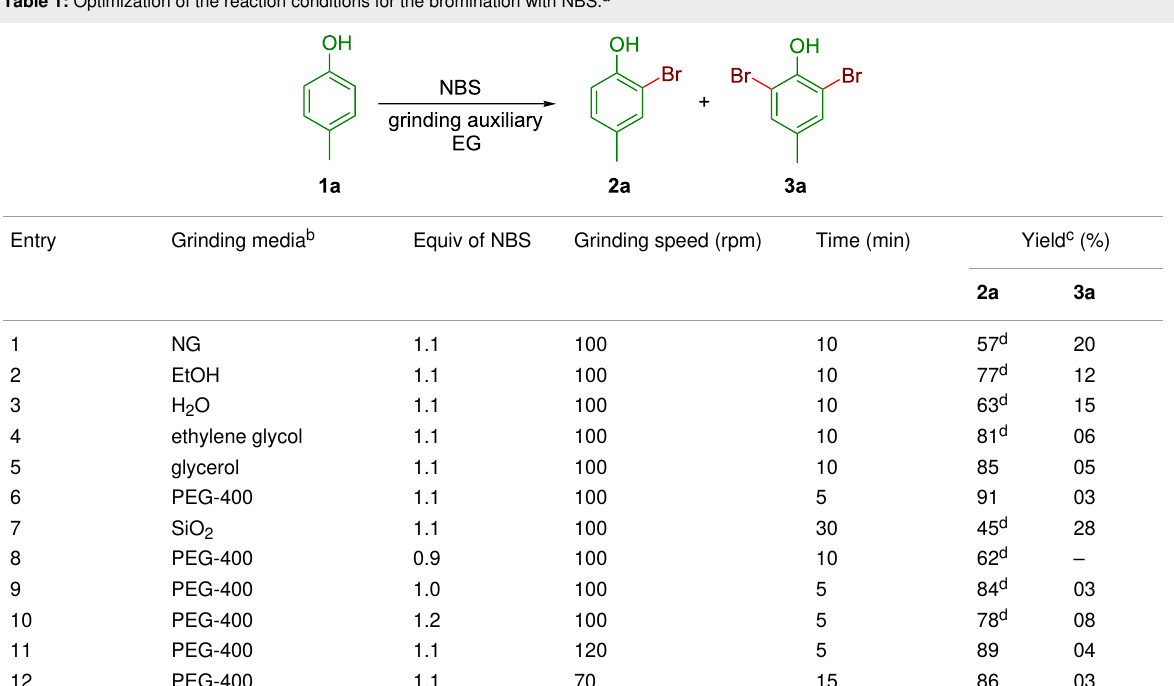
Table 1: Optimization of the reaction conditions for the bromination with NBS.